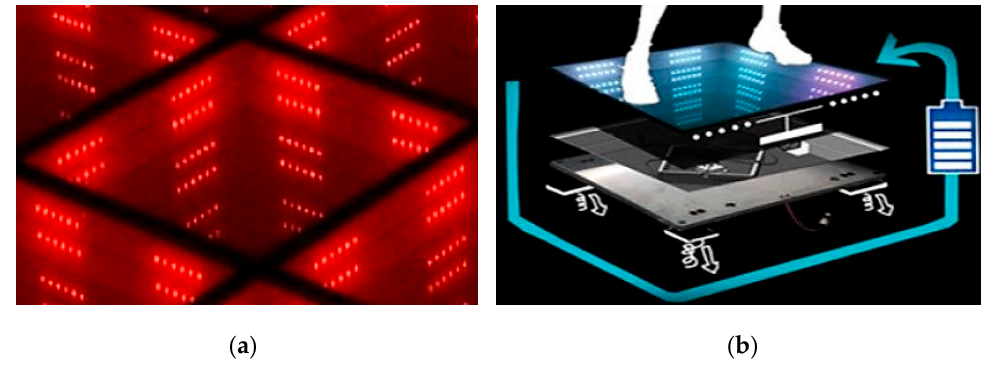
Figure 32. Sustainable Dance Floor ® ( a ), and a cross-section of the harvester ( b ) [75].